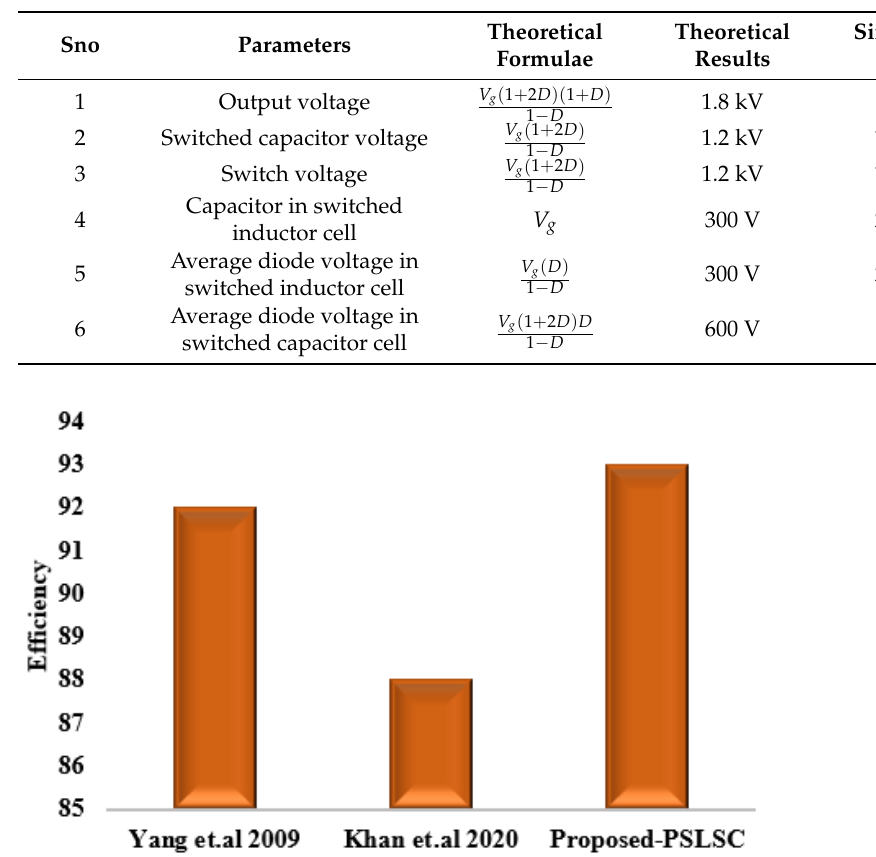
Figure 12. Efficiency comparison at the rated power [33,57].